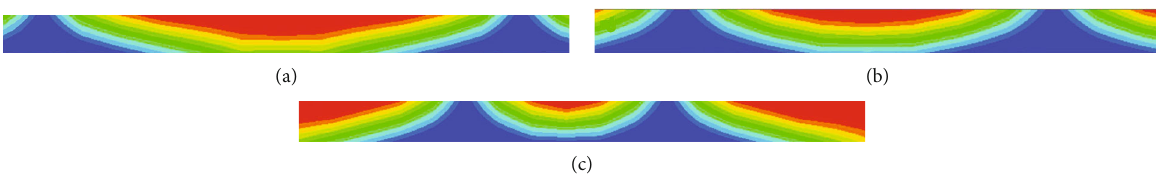
Figure 11: In fl uence of an adjacent well on the shape and water saturation distribution in the water cone through physical simulation.